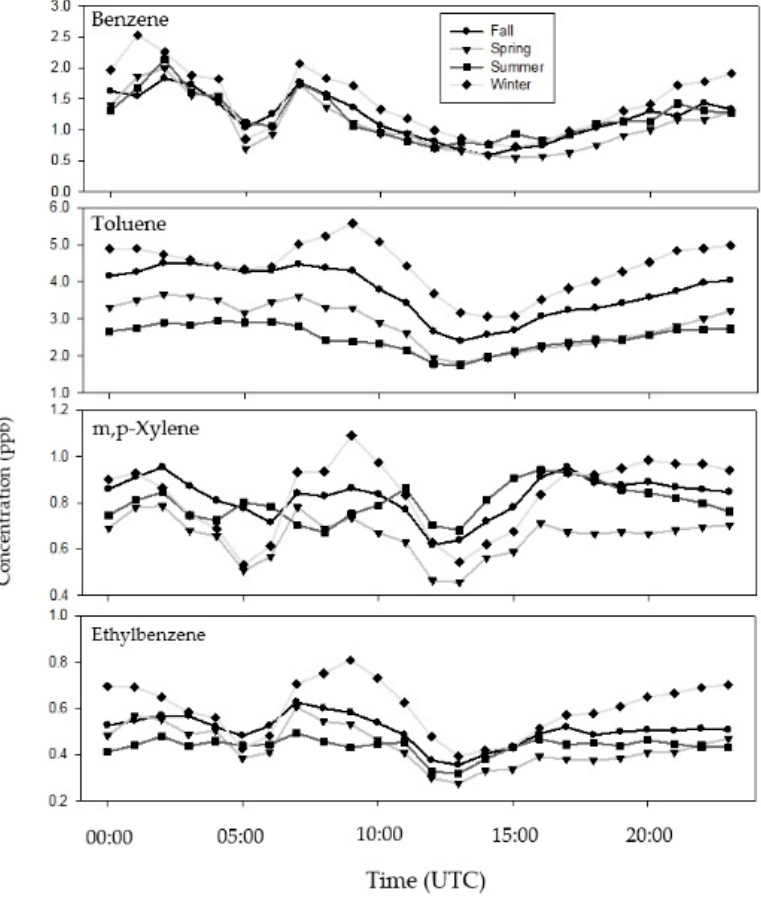
Figure 1. The diurnal variation in the BTEX (benzene, toluene, ethylbenzene, and xylenes) concentrations for each season, averaged over 17 sampling sites. for each season, averaged over 17 sampling